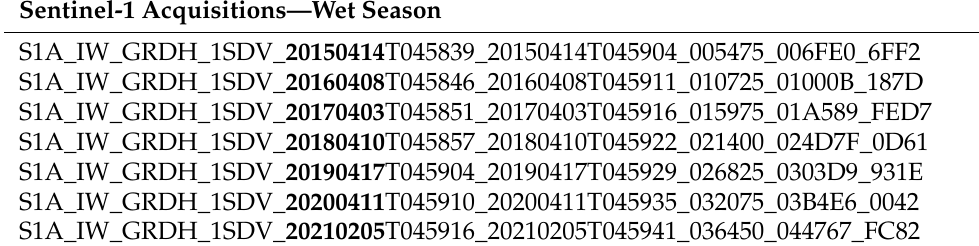
Table 2. SAR products downloaded from the Alaska Satellite Facility’s data portal (ASF DAAC). Wet season acquisition dates are highlighted in bold font.